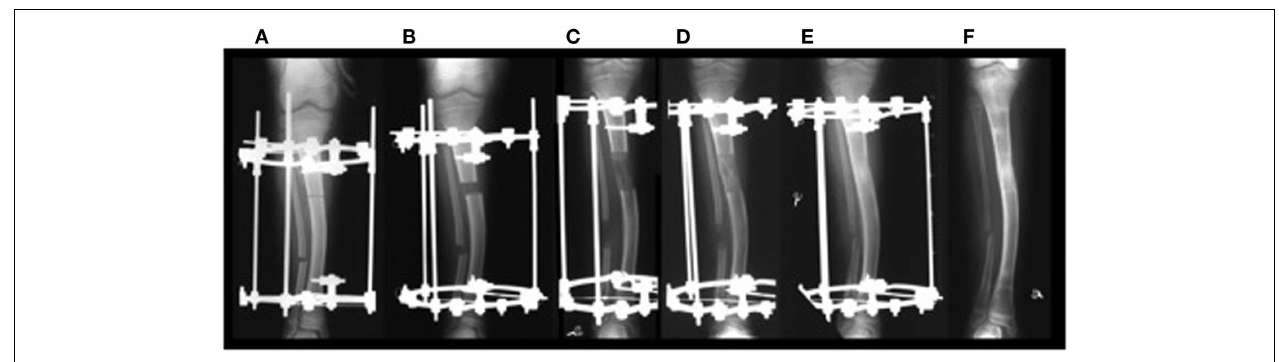
FIGURE 1 | (A) Application of distractor; (B) start of distraction; (C) end of distraction; (D,E) consolidation phase without any distraction until bone in the distraction gap consolidates; (F) removal of distractor. ©2012 Hamdy et al. (7).